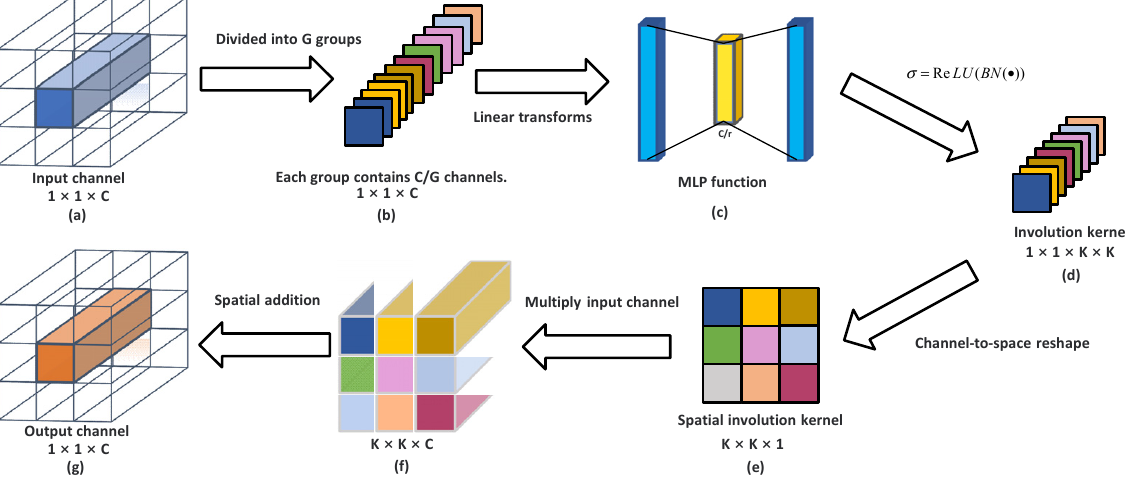
Figure 1. Schematic illustration of involution. ( a ) is the input channel, ( b ) is to divide all input channels into G groups, ( c ) is the linear activation layer, ( d ) is the involution kernel after ReLU activation, ( e ) is the spatial alignment of the involution kernel, ( f ) is the result of multiplying the involution kernel on space with the input channel, and ( g ) is the result of adding ( f ) on the spatial range.